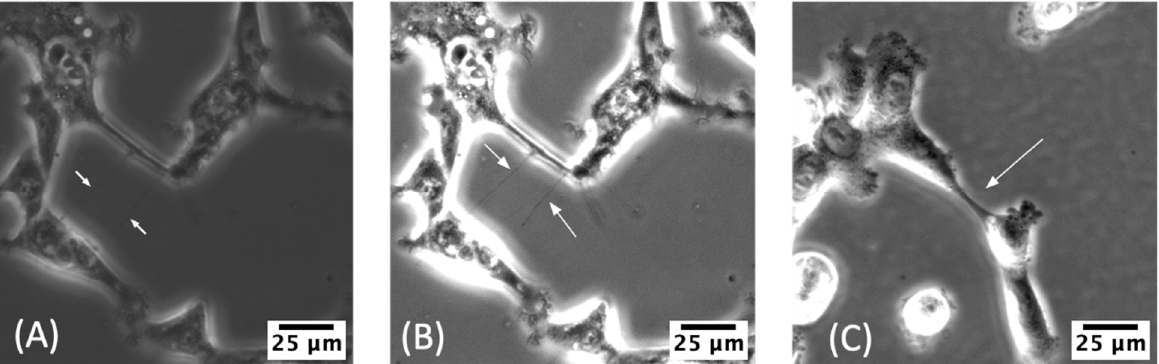
Figure 1. ( A ) Two TNTs that were successfully captured by the deep learning model (true positives). ( B ) The image from ( A ) is enhanced for improved TNT visibility. ( C ) A TNT-appearing structure that was mistakenly identified as a TNT by the model (false positive). Images ( B , C ) were generated with Fiji software and were adjusted for their brightness and contrast by setting minimum and maximum displayed value to 20 and 100, respectively, for improved visibility of the structures (this image modification is not necessary for the deep learning model to work).